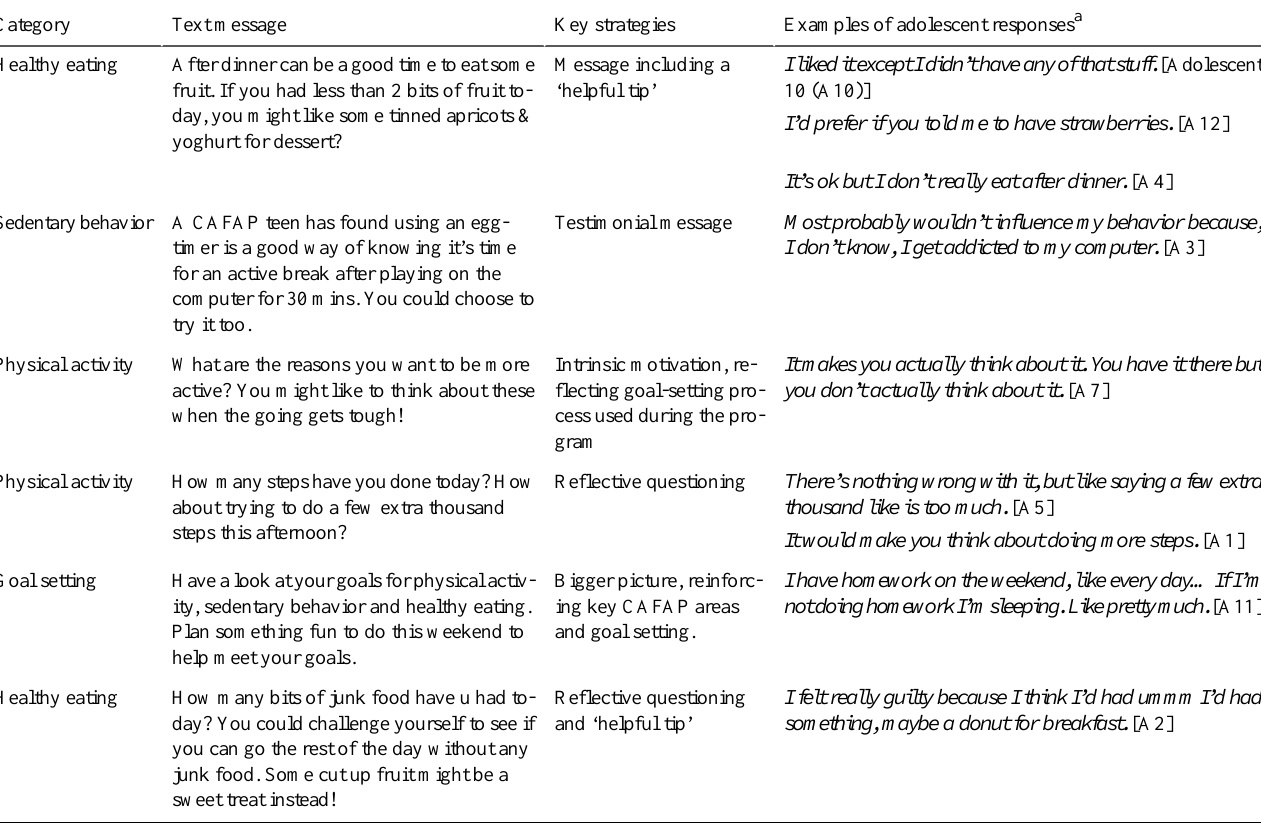
Table 1. Text message examples used to represent the content of text messages used in the intervention and typical adolescent responses from focus groups.